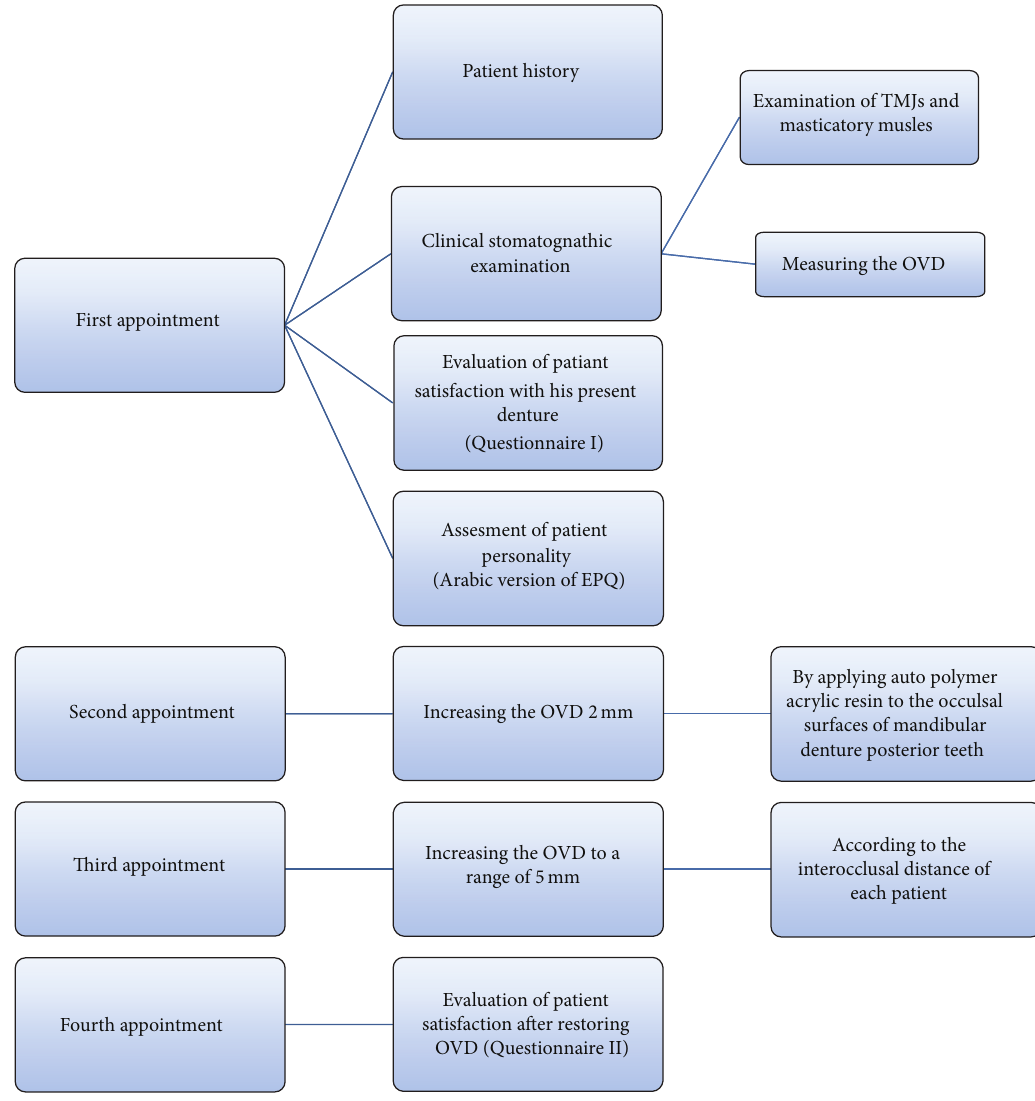
Figure 1: Patients were recalled for three visits after first appointment at two-week intervals (OVD: occlusal vertical dimension).